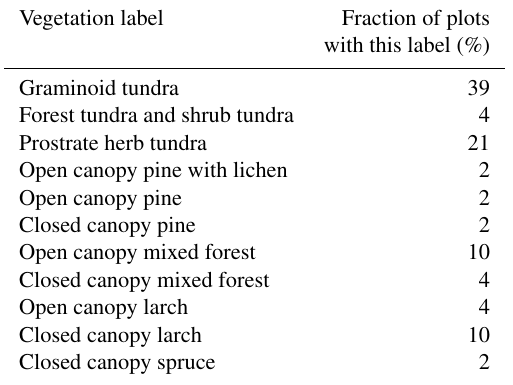
Table 2. Vegetation class labels per plot and percentage of plots for each